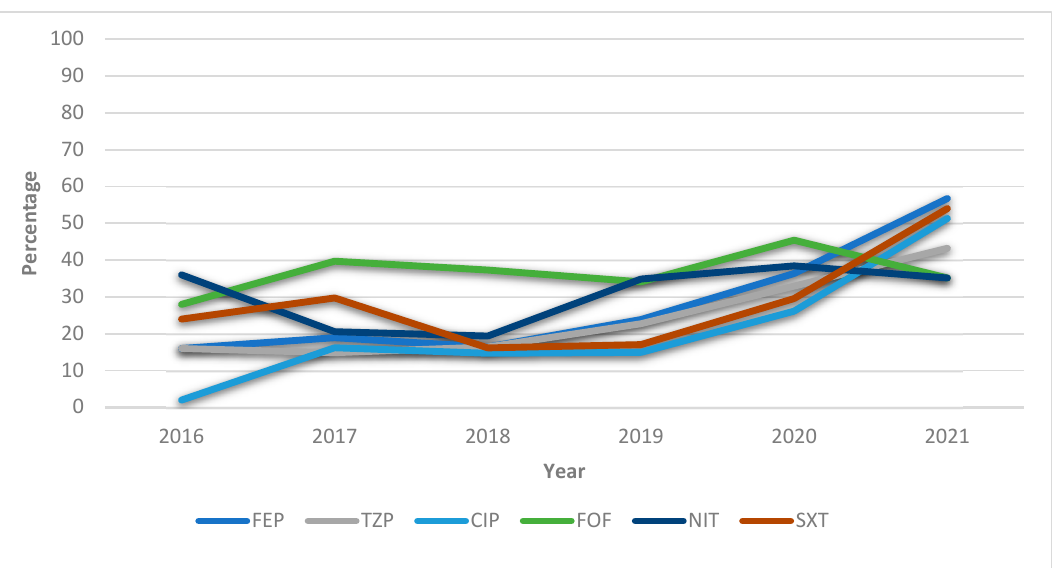
Figure 1. General annualized resistances (%) of Enterobacter cloacae during 2016–2021 against the antibiotics most frequently used to treat UTIs. FEP = cefepime; TZP = piperacillin–tazobactam; CIP = ciprofloxacin; FOF = fosfomycin; NIT = nitrofurantoin; SXT = trimethoprim–sulfamethoxazole.